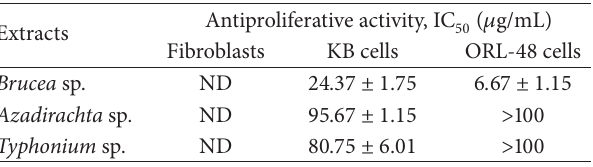
Table 1: The IC of Brucea sp., Azadirachta sp., and Typhonium sp. 50 extracts on KB and ORL-48 cancer cells. Fibroblasts represented as normal cells in the